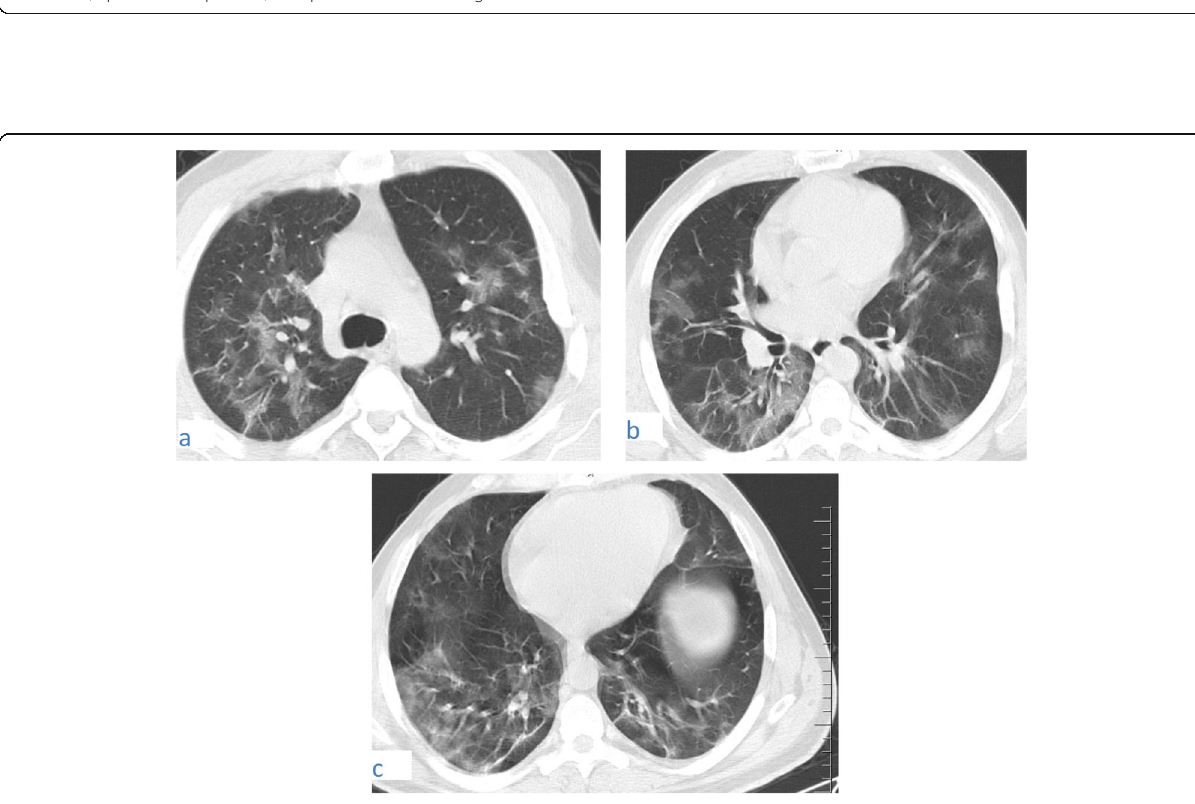
Fig. 14 A 38-year-old male patient with COVID-19. CT chest axial images ( a ), ( b ), and ( c ) show subpleural and patchy ground glass opacities with vascular thickening, and show bilateral basal subpleural areas of ground glass opacities, fibrous stripes, architectural distortion, and perilobular